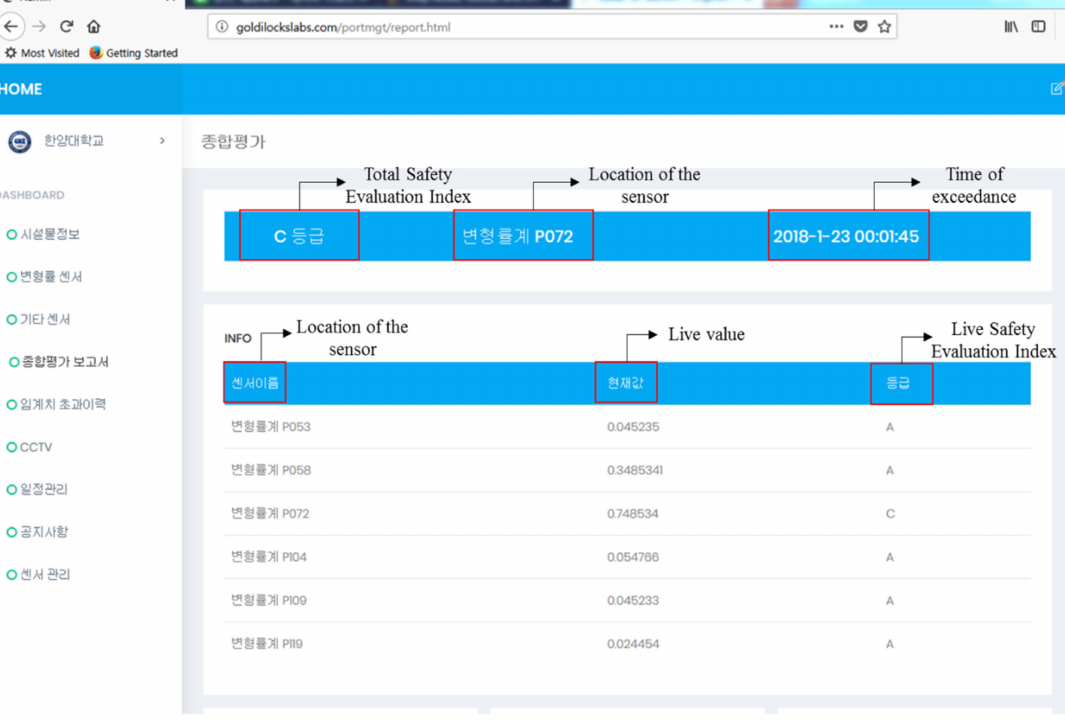
Figure 13. Page for monitoring the Marayng